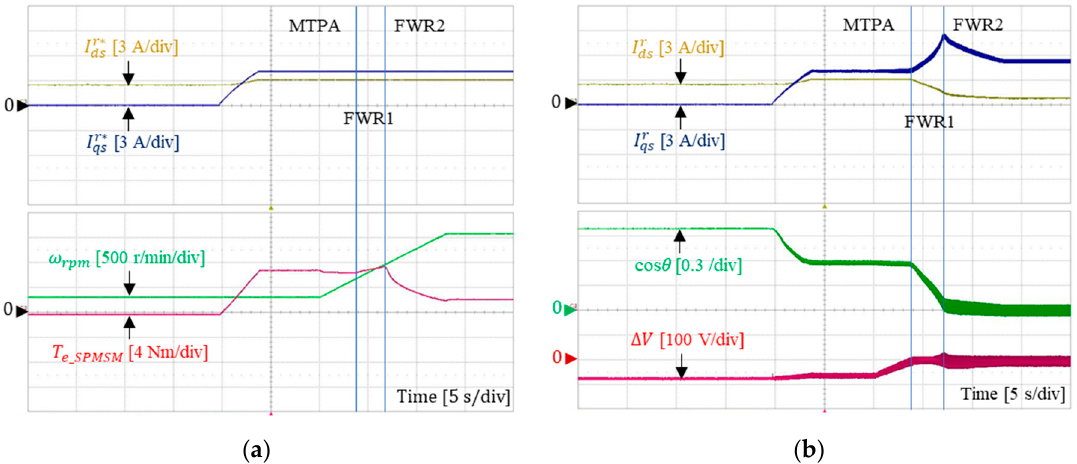
Figure 12. Experimental results with the apparent inductance of the self-axis flux saturation model: ( a ) maximum torque per ampere (MTPA) current reference and experimental conditions and ( b ) operation of the proposed algorithm.